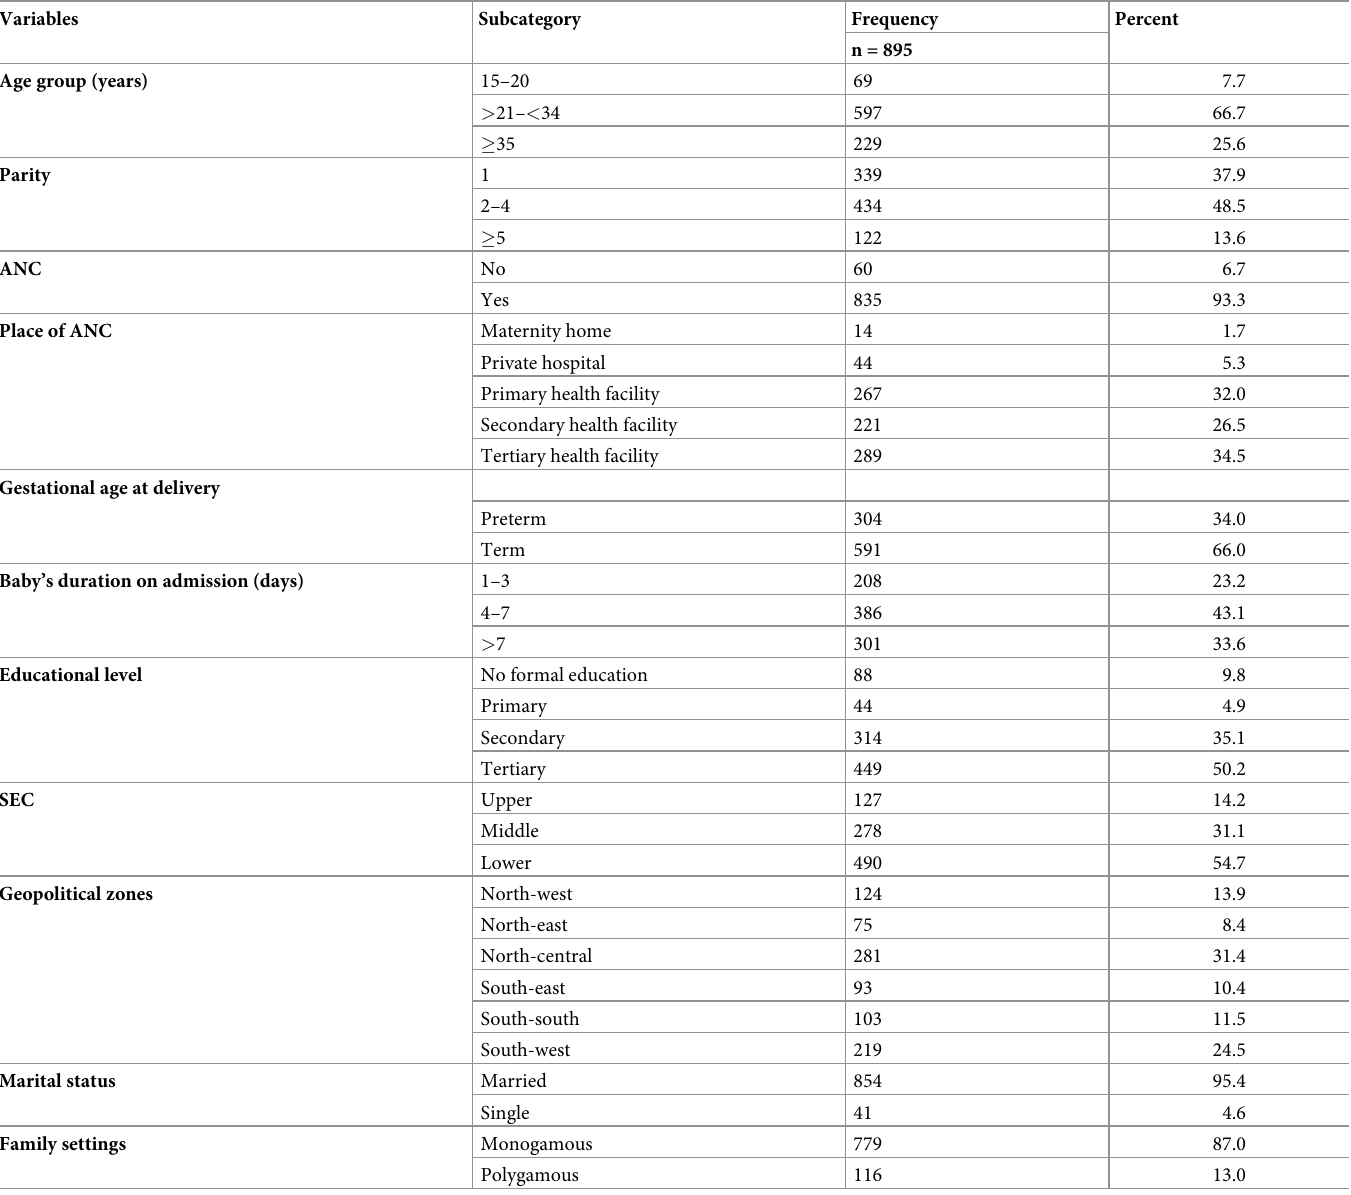
Table 1. General characteristics of the study